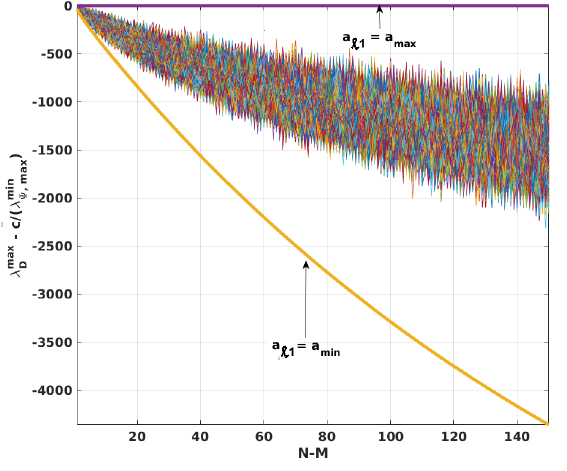
c Figure A1. Comparison of λ max and with different ( N − M ) . Lower and upper limits are D λ min Ψ , max shown ∀ a (cid:96) 1 = a min and a (cid:96) 1 = a max , respectively. This figure can be regenerated for Ψ sub with the Matlab program, matlab_prog_figures_3_A1.m provided in the supplementary